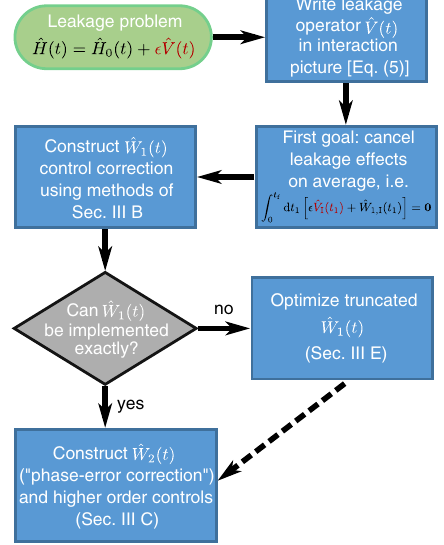
FIG. 2. Flowchart illustrating the first few steps of the Magnus- based